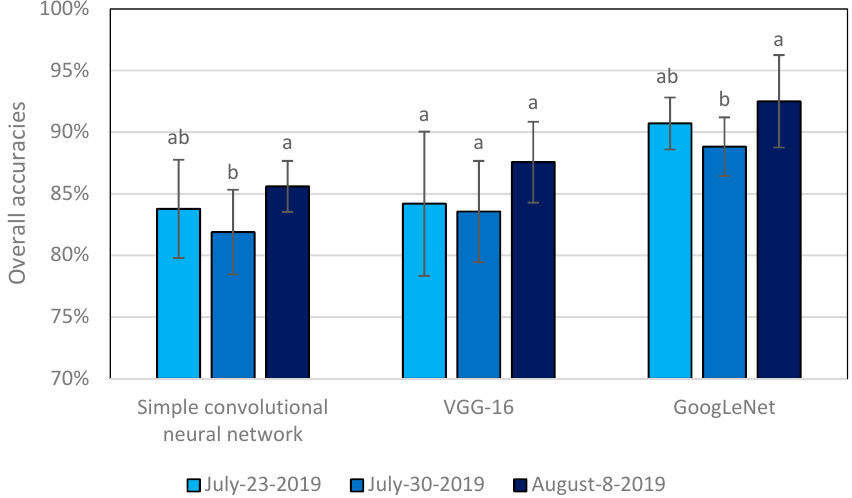
Figure 16. Accuracy comparisons of di ff erent dates datasets for di ff erent deep learning algorithms (simple convolutional neural network, VGG-16, and GoogLeNet). Whiskers on bars represent two standard deviations calculated from 10 replicates. Bars with di ff erent letters are significantly di ff erent by Tukey’s test at 0.05 significance